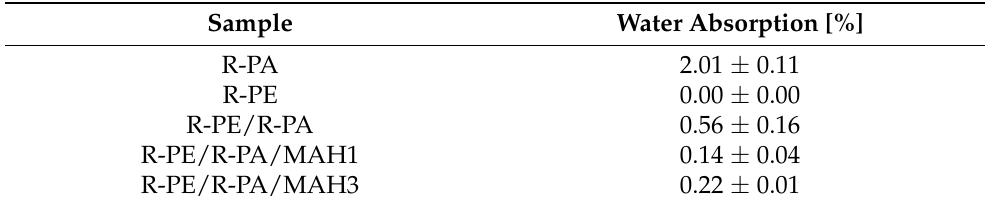
Table 3. Water absorption test results of samples.